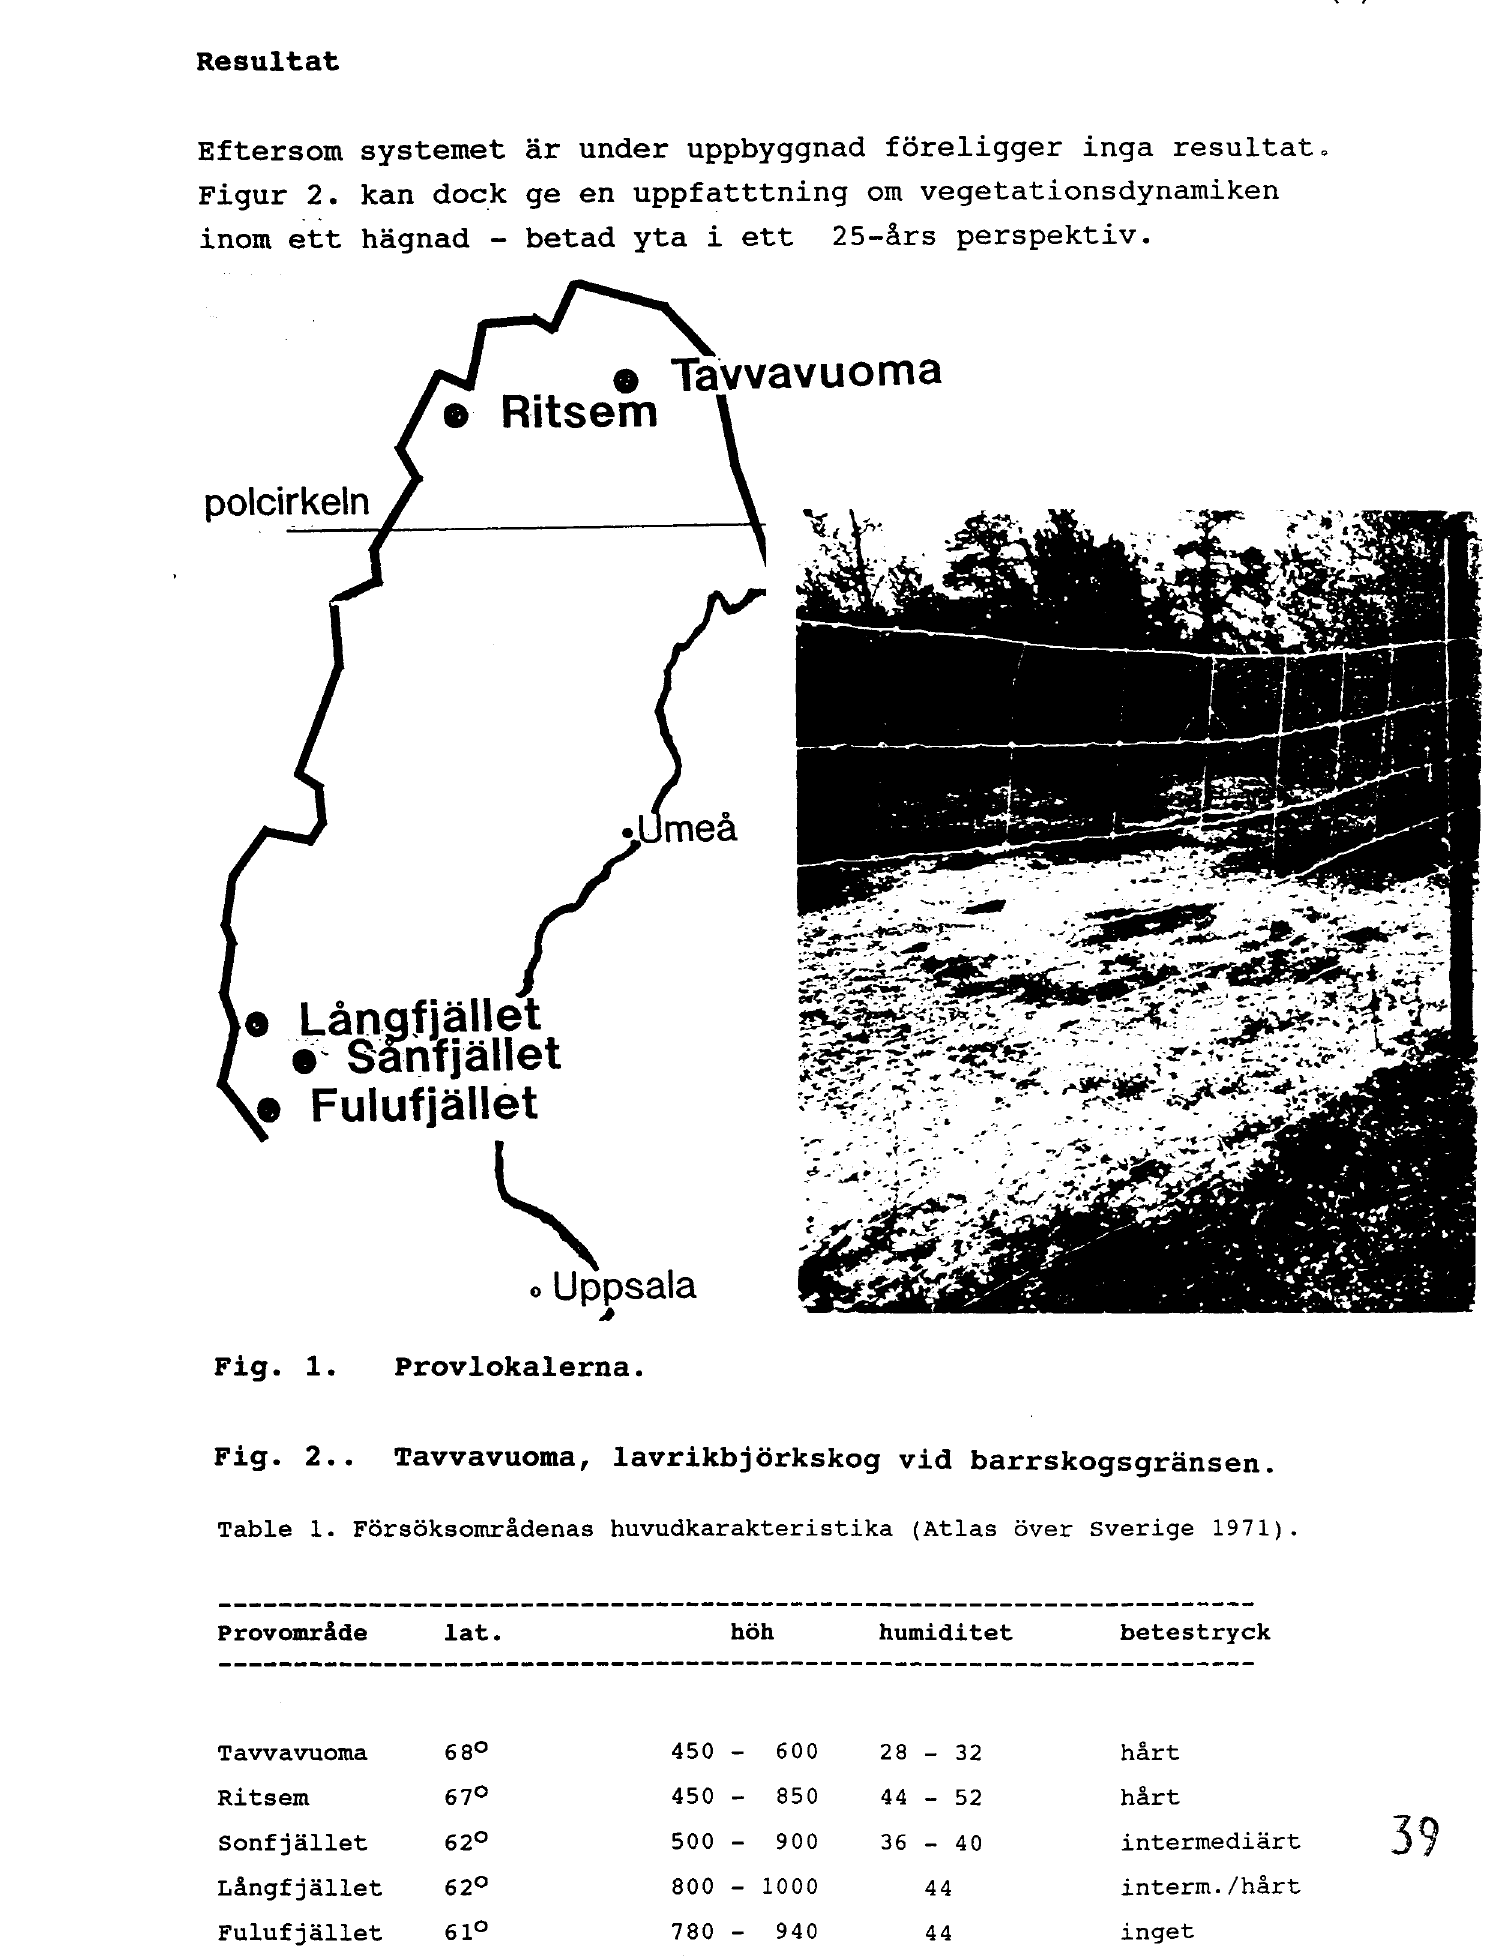
Sonfjållet Långfjållet 44 interm./hårt Fulufjållet